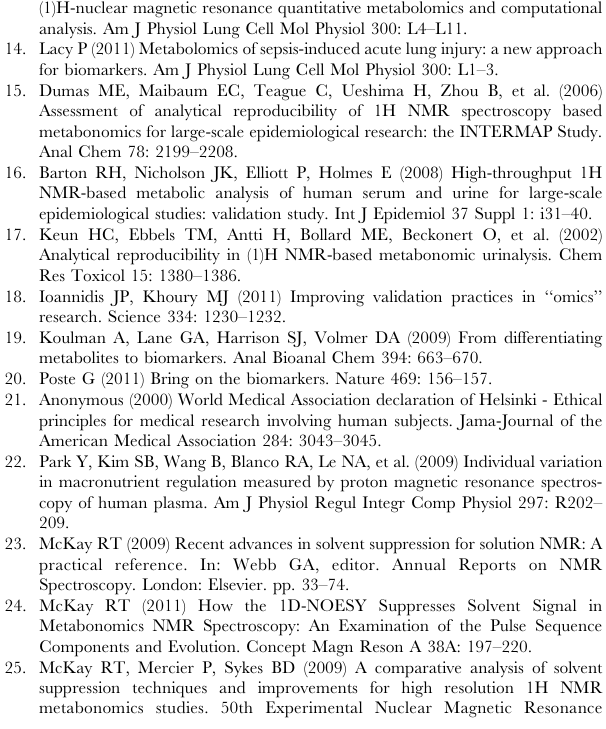
Figure S1 Different creatinine and urea concentrations were acquired using a 3 mm and 5 mm NMR probe. Figure S2 There was a high degree of correlation between normalized metabolite concentrations obtained from the University of Alberta’s and the University of Michigan’s 5 mm probes. Linear regression plots (Pearson) with associated 95% prediction bands (dashed lines) of normalized urine metabolites from 1 H-NMR spectra acquired using 5 mm probes at the University of Michigan (UM) and at the University of Alberta (UA). Figure S3 Box and whisker plots of the 59 urine metabolites quantified from 1 H-NMR spectra acquired from technical replicate samples using a 5 mm probe (University of Alberta; UA), and a 3 and 5 mm probe at the University of Michigan (UM).